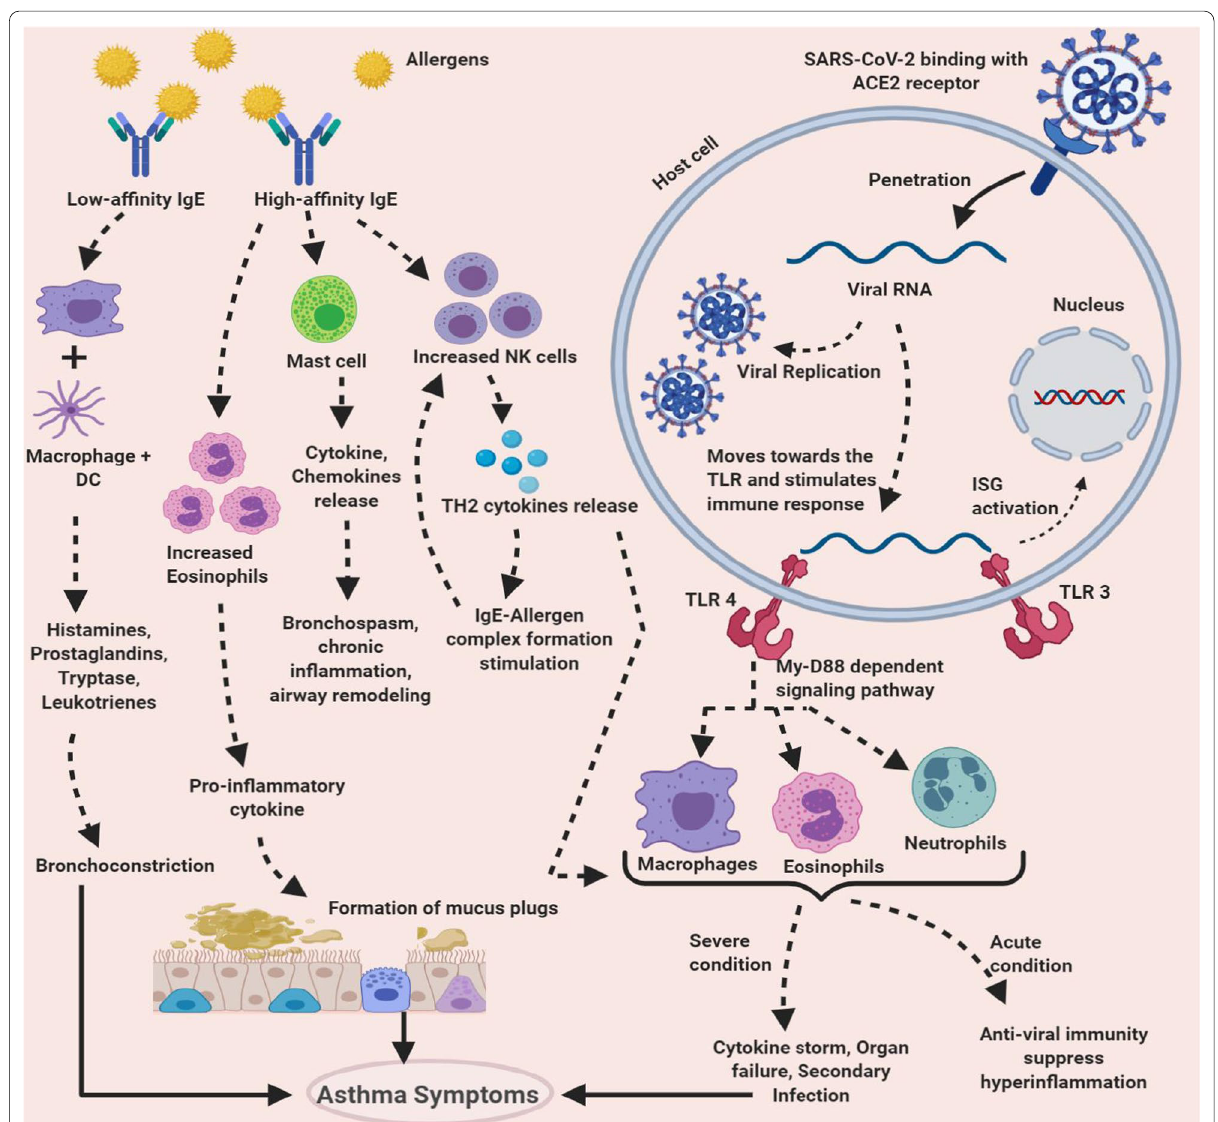
Fig. 1 The pathophysiology of SARS-CoV-2 and allergic asthma. SARS-CoV-2 binds to the ACE2 receptor and injects its RNA inside the host cell. The dsRNA triggers TLR3 and TLR4 leading to ISG activation and recruitment of immune cells. In severe conditions, the immune cells lead to cytokine storms which can trigger asthma symptoms. On the other hand, allergens can form complexes with high-affinity IgE and low-affinity IgE, which can trigger immune cells to release cytokines and other mediators that lead to the formation of mucus plugs, bronchoconstriction, airway remodeling, and other asthma symptoms. In SARS-CoV-2 patients with asthma, the recruitment of immune cells and the release of cytokines from both pathways can lead to severe organ damage and other harmful effects. This picture was created with BioRender and downloaded with a